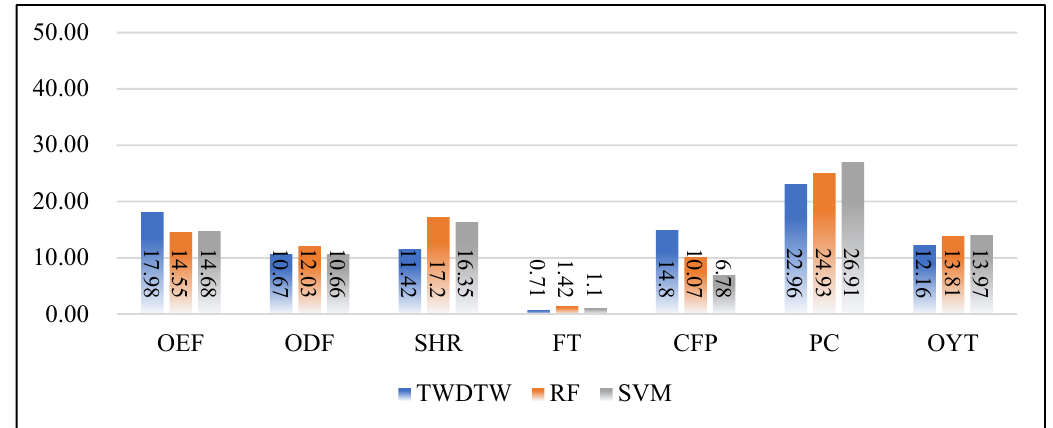
Figure 5. Area ratio (%) of forest types, where OEF represents other evergreen forests, ODF represents other deciduous forests, SHR represents shrubs, FT represents fruit trees, CFP represent Chinese fir plantations, PC represents pine and cypress trees, and OYT represents oil-yielding trees.